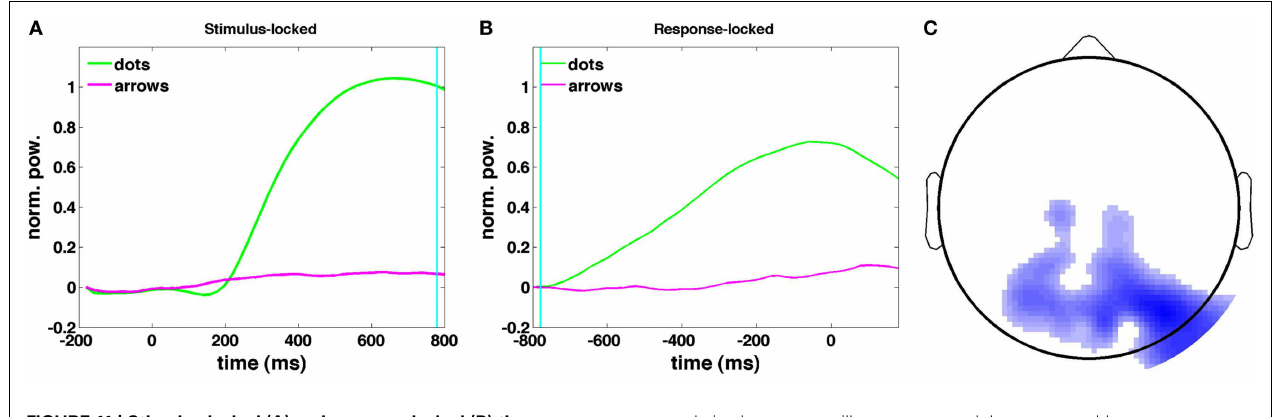
FIGURE 11 | Stimulus-locked (A) and response-locked (B) time courses of the canonical correlate in the 4–9Hz theta band, correlated with the dots upramp, cyan line indicates RT in (A) and dots onset in (B). (C) Dots upramp topography (red indicates a positive